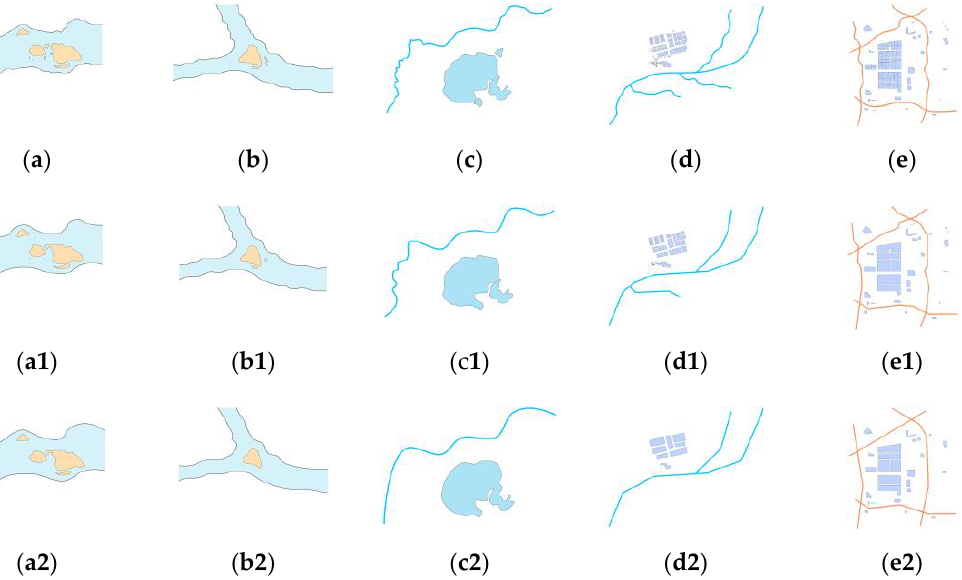
Figure 17. Generalization results of micro scenes: ( a – e ) original data; ( a1 – e1 ) the results of the first generalization; ( a2 – e2 ) the results of the second generalization. Table 2. Calculation results produced by the method proposed in this paper.